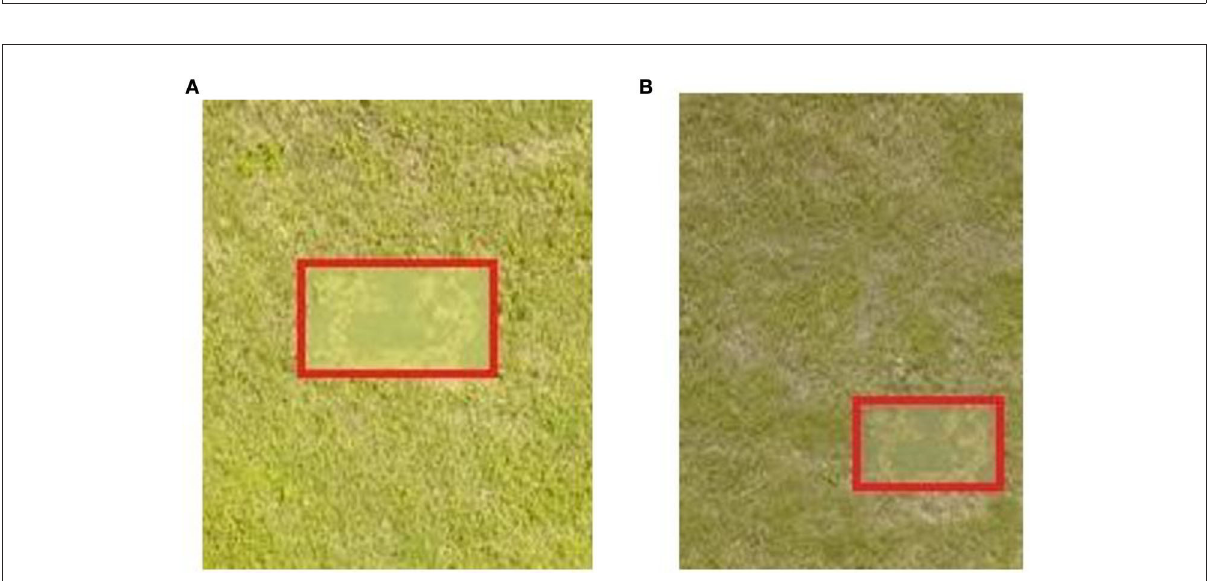
FIGURE16 1 * 0.6m test piece.